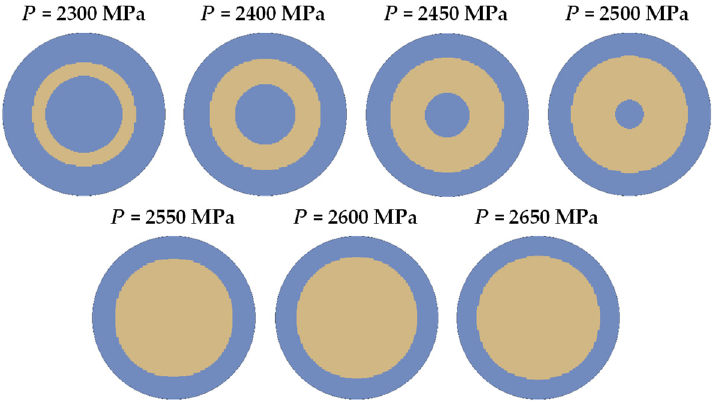
Figure 16. Predicted stripping patterns for different values of maximum applied pressure. Alumi- num’s thickness is 0.97 mm, epoxy’s thickness is 25 μ m and spot diameter is 4